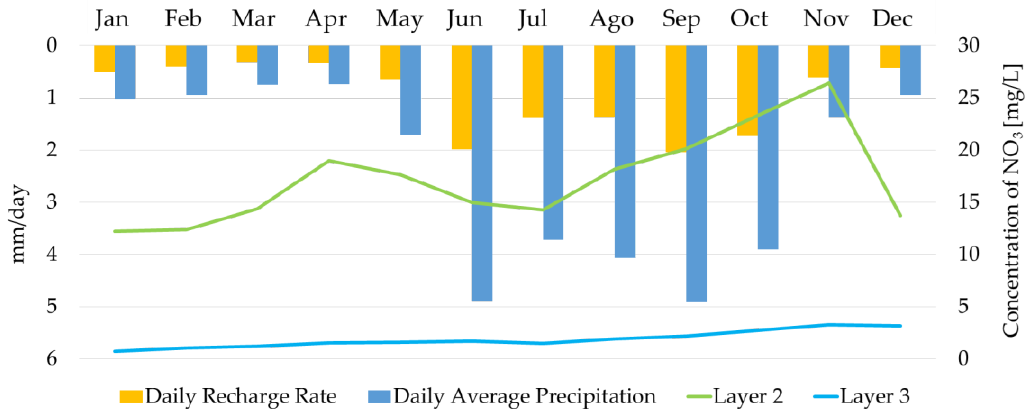
Figure 10. Relationship between recharge and NO 3 concentration in Progreso City according the model.